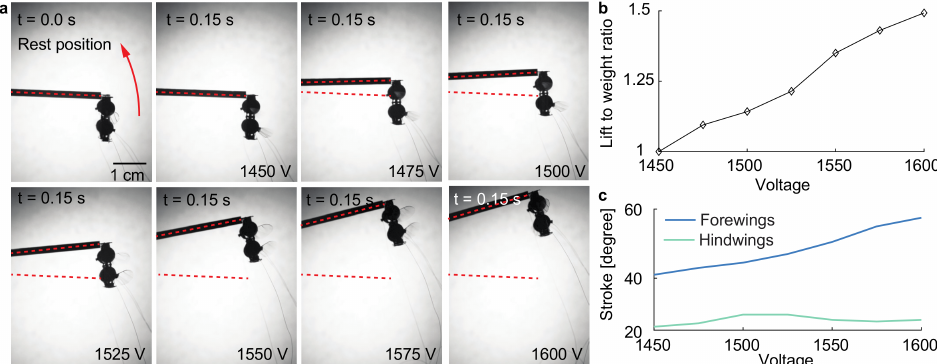
Figure 8. Effect of driving amplitude V amp on lift force production. ( a ) Final robot liftoff positions at driving frequencies ranging from 1450 V to 1600 V. ( b ) Robot lift-to-weight ratio as a function of driving voltage amplitude. ( c ) Forewing and hindwing stroke amplitudes as a function of V amp